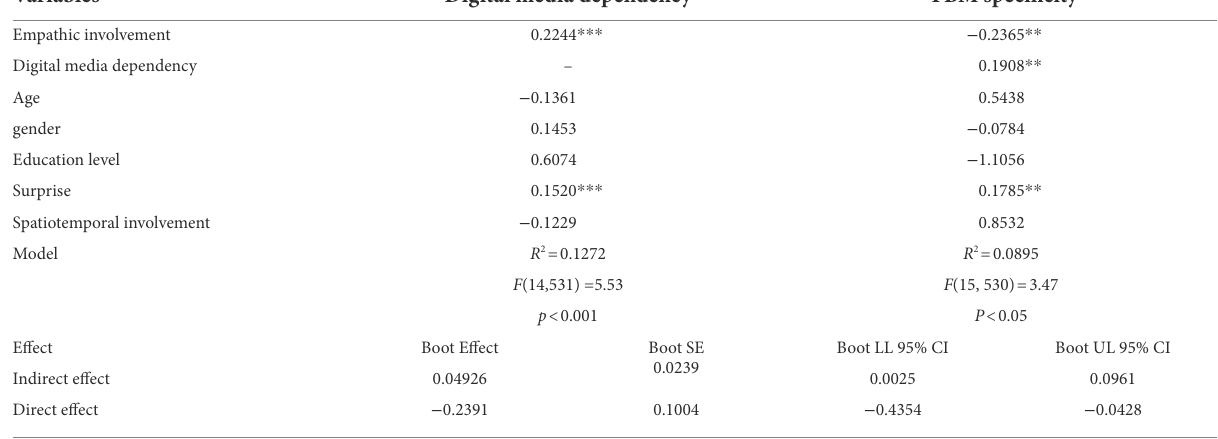
TABLE 5 Bootstrapping: Mediation effect